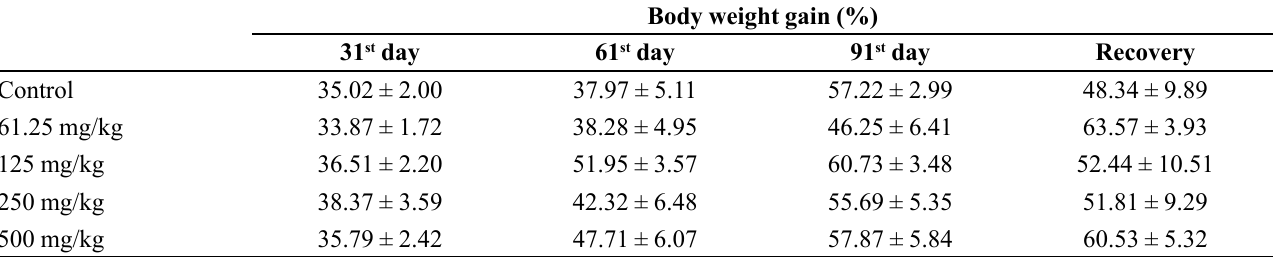
Values are presented as mean ± Standard error of mean (n =5). p>0.05: Not statistically significantly different from control group.